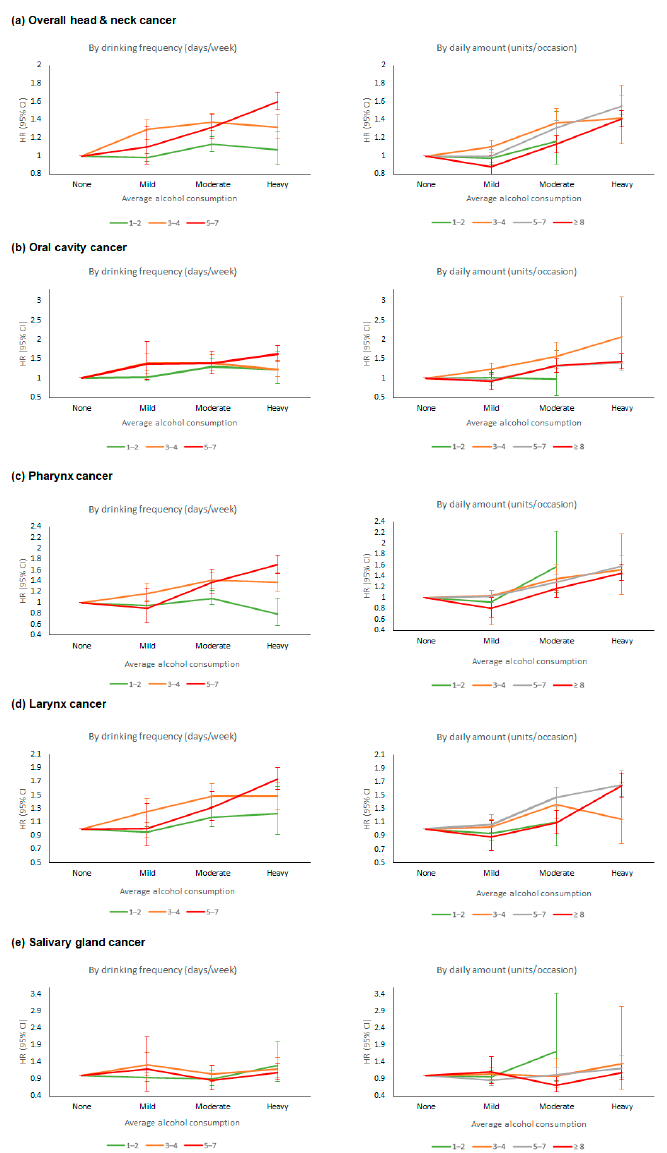
Figure 2. Risk of head & neck cancer stratified by average alcohol consumption: Impact of drinking frequency versus daily amount. ( a ) overall head & neck cancer, ( b ) oral cavity cancer, ( c ) pharynx cancer, ( d ) larynx cancer, ( e ) salivary gland cancer . HR, hazard ratio; CI, confidence interval . HRs are adjusted for age, sex, income, smoking status, physical activity, body mass index, and diabetes mellitus .